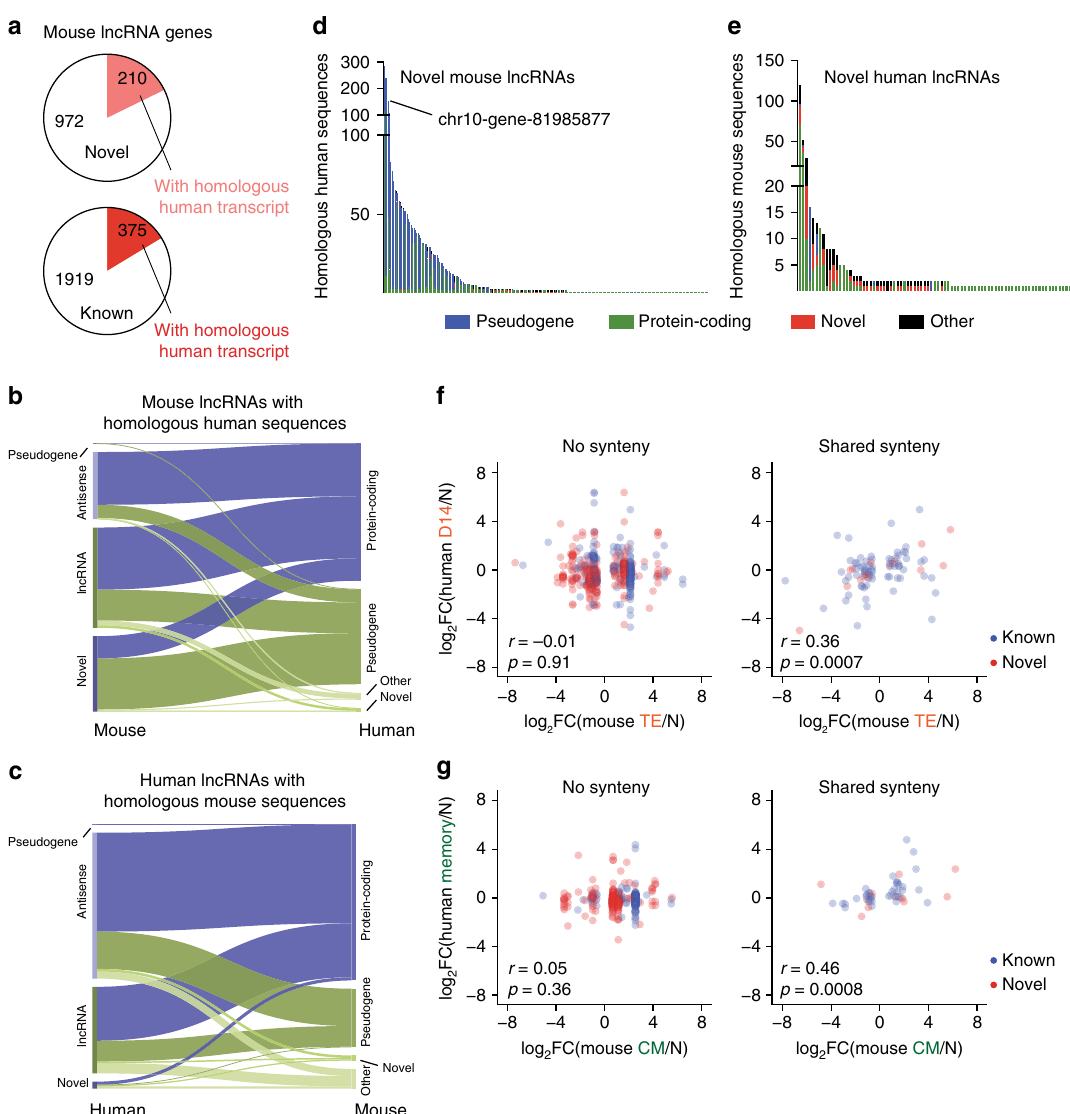
Fig. 7 lncRNAs with conserved sequence and shared synteny exhibit similar expression patterns in human and mouse CD8 + T cell differentiation. a Number of novel and previously annotated mouse lncRNA genes with detectable sequence homology to a human transcript. b , c Composition of noncoding RNA with any homolog in the opposite species. d Number and biotype of homologs of novel mouse genes with signi fi cant sequence similarity to human genes (210). e Number and biotype of homologs of novel human genes with signi fi cant sequence similarity to mouse genes (96). f , g Correlation of expression changes in homologous lncRNAs with or without shared synteny. In panels ( f ) and ( g ), Pearson ’ s r is shown, with p -value calculated using a t